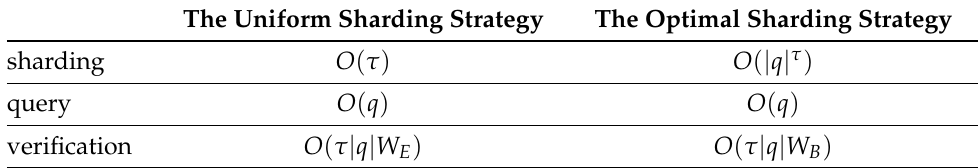
Table 3. Time overhead of sharding